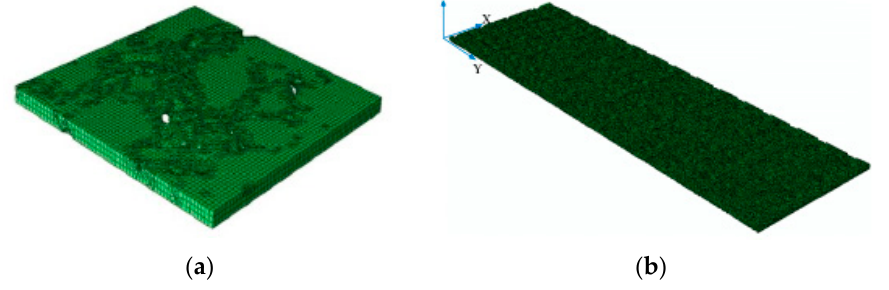
Figure 5. Pavement modeling: ( a ) SMA pavement model and ( b ) extended SMA pavement model.